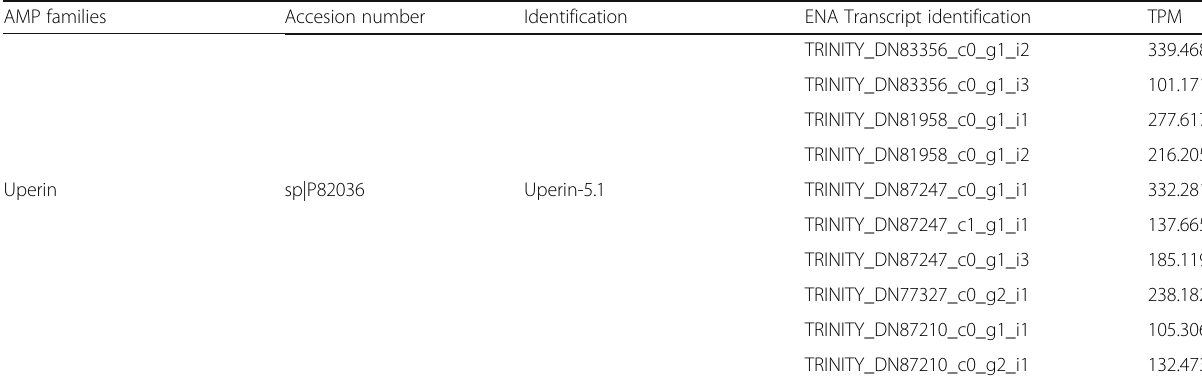
Table 2 List of main antimicrobial peptides from transcriptome (Continued) AMP